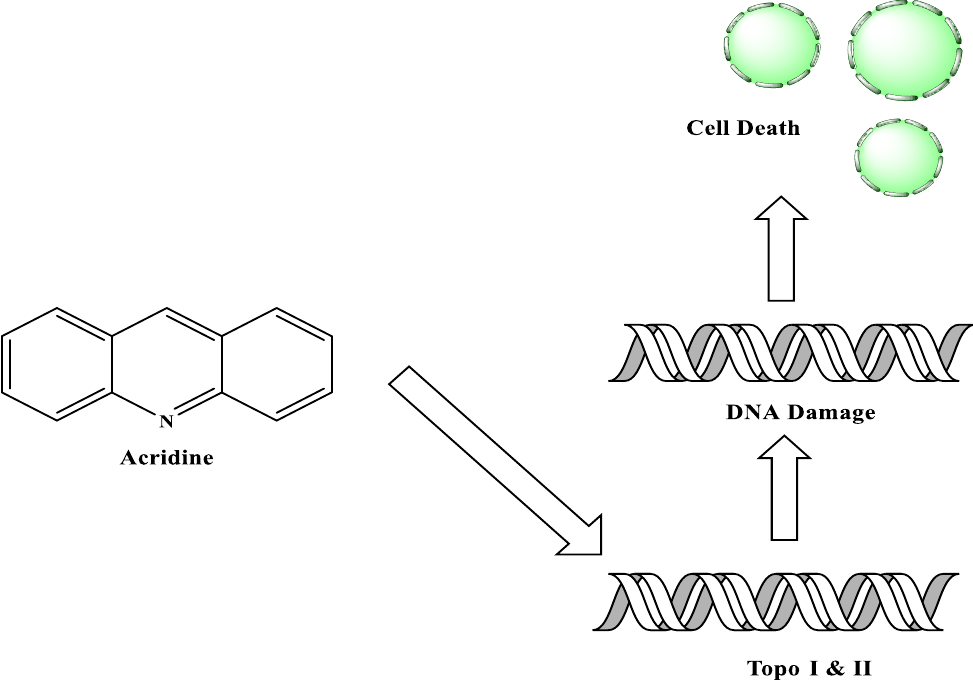
Table 1. Acridine as an anti-tumour